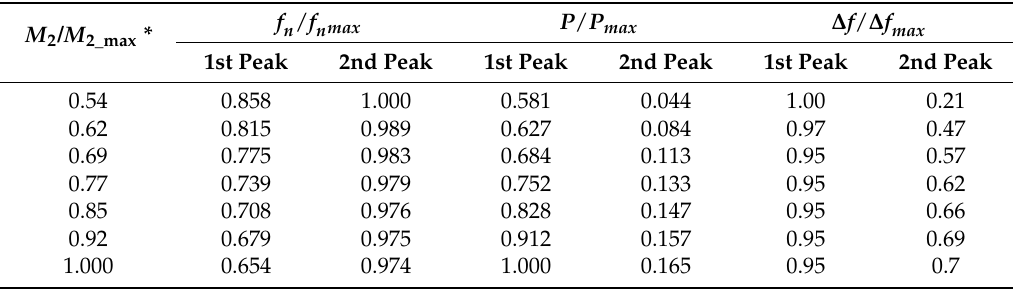
Table A4. Two bimorphs interconnected by a spring system—the influence of the normalized M 2 on the normalized natural frequencies, harvested power, and bandwidth.